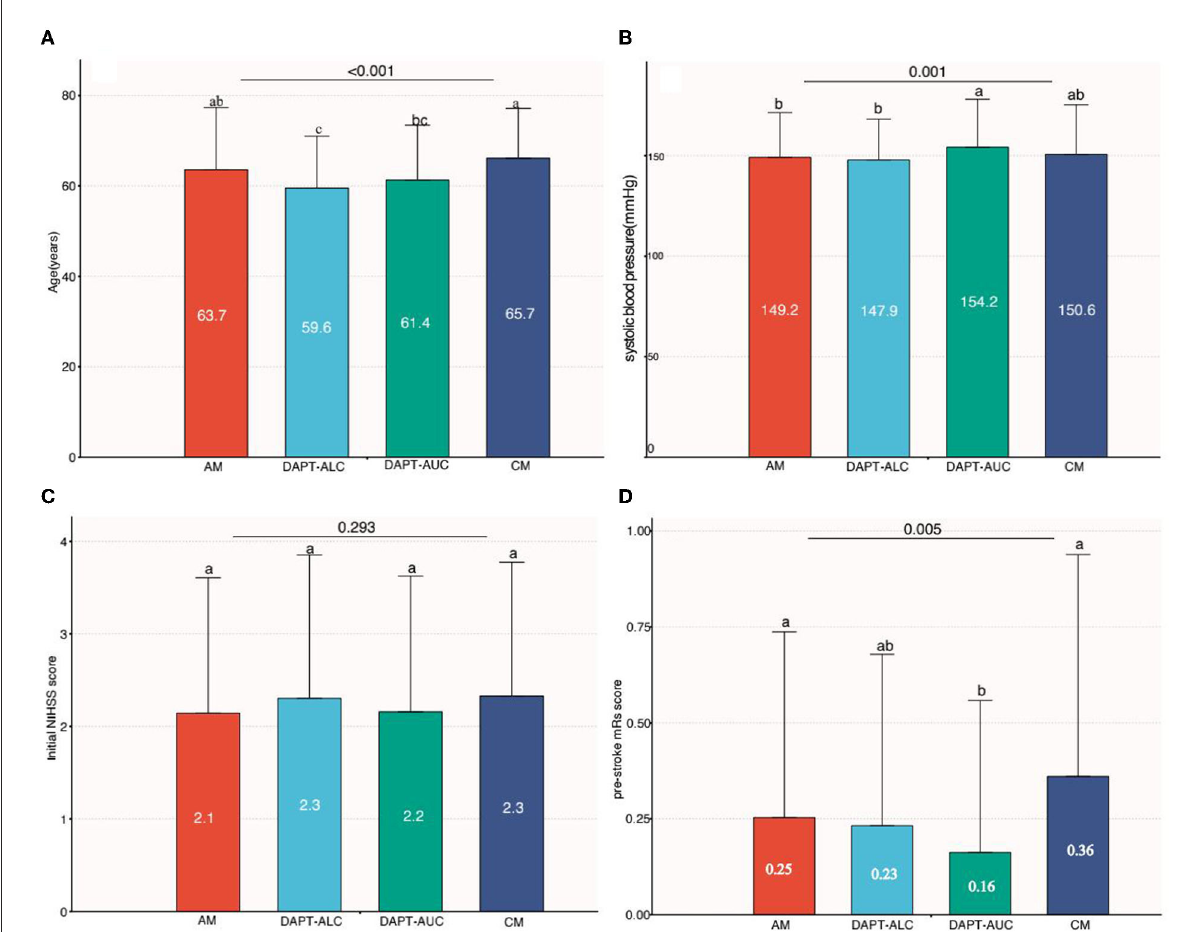
FIGURE2 Comparison among groups of continuous variables (age, systolic blood pressure, NIHSS score and pre-stroke mRs score). (A) Comparison of age among four groups. (B) Comparison of baseline systolic blood pressure among four groups. (C) Comparison of baseline NIHSS scores among four groups. (D) Comparison of pre-stroke mRs scores among four groups [a and b indicate that when the two groups are compared, if the letters between the two groups are the same, there is no significant difference (e.g., a vs. a, P > 0.05), and if the letters between the two groups are different, there is a significant difference between the two groups (e.g., a vs. b, P <